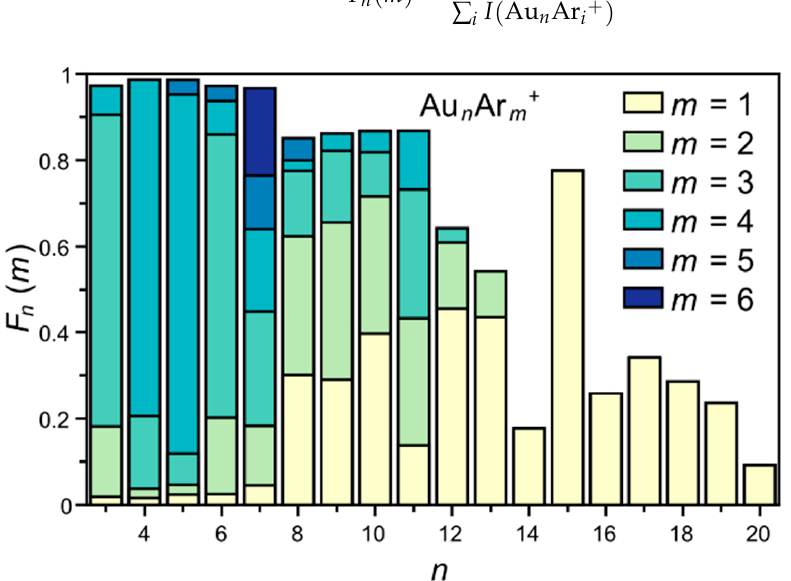
Figure 1. Fractional distribution of adsorbed Ar atoms in Au n Ar m + ( n = 3–20, m = 1–6) clusters, plotted as a stacked bar chart.